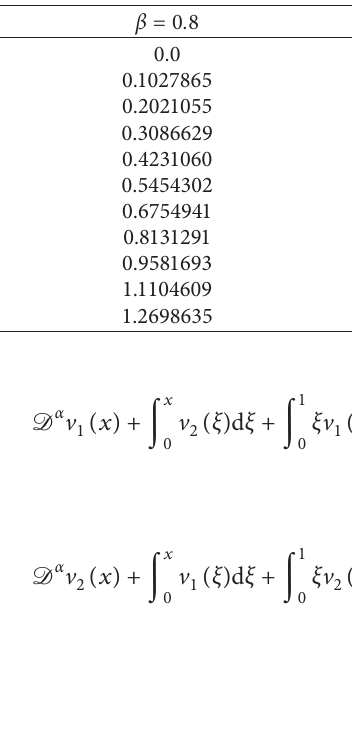
Table 6: Numerical results of exact v